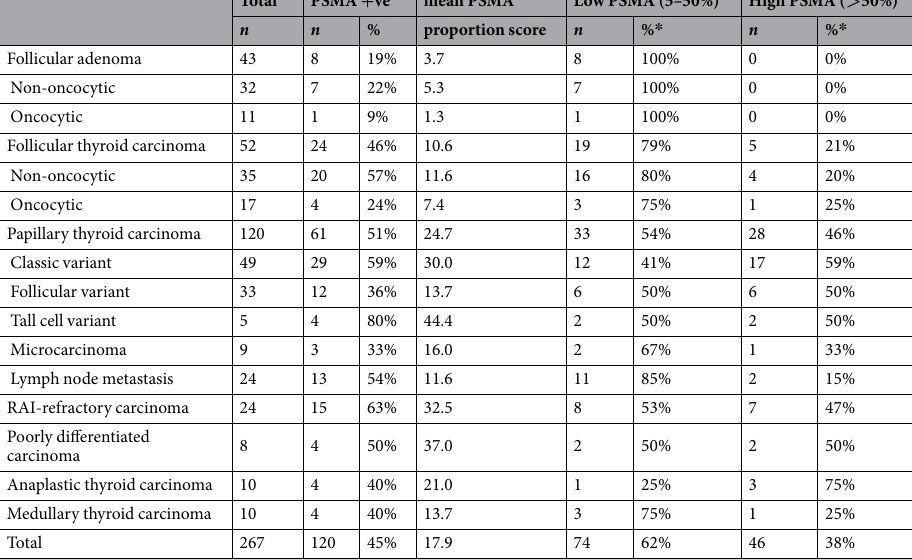
Clinical significance of endothelial PSMA expression in thyroid tumors.